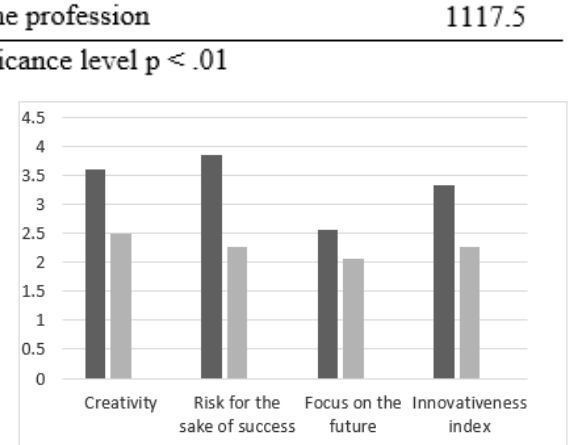
Figure 1. Results of differences (aver - age values) on “Scale of self-assessment of the person’s innovative qualities “ scales method - ology (N. M. Lebedeva, A. N. Tatarko) (Group 1 – involved, Group 2 – not involved).